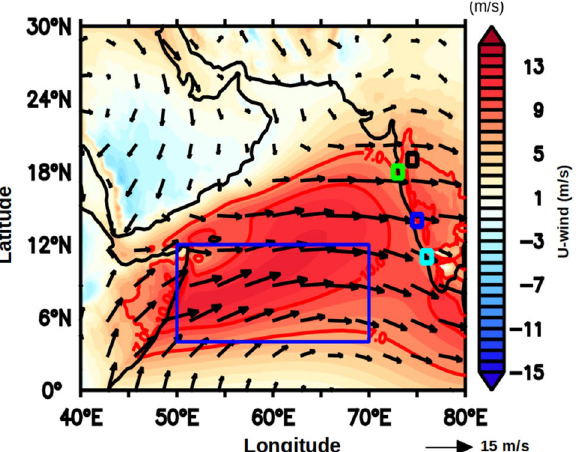
Figure 1. Climatological mean wind vector overlaid on zonal wind (u-wind, m/s) during June to September (JJAS) at 850 hPa in the Arabian Sea. The blue box (50–70°E and 4–12°N) represents the region within which parameters were averaged. Red solid lines indicate the zonal wind speed contours of 7 m/s and 10 m/s. The different colour small squares represent the location of sub-divisonal stations, Madhya Maharashtra (black), Konkan (green), Coastal Karnataka (blue), and Kerala